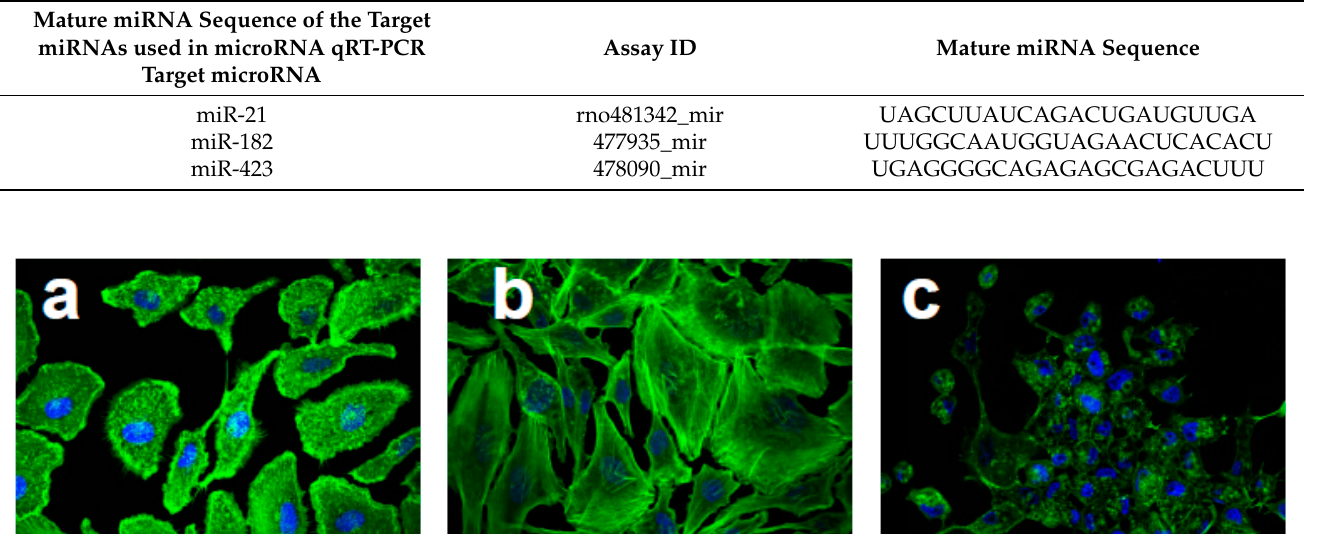
Table 2. Target microRNA sequences.